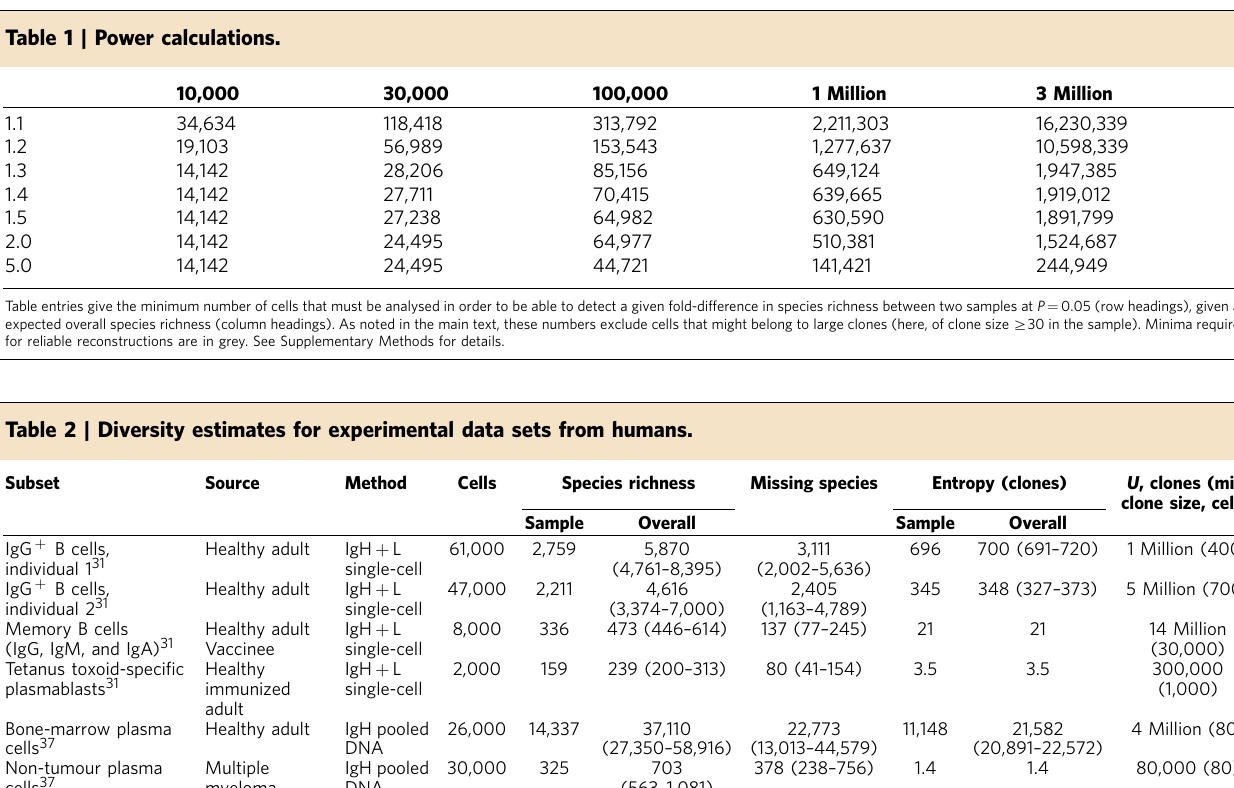
Table 1 | Power calculations.